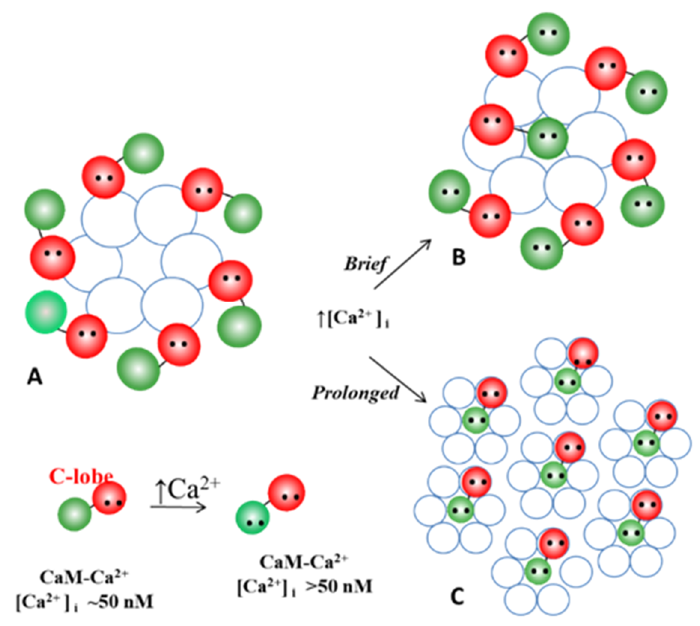
Figure 17. We are proposing that with exposure to high [Ca 2+ ] i , non-gating CaM molecules, bound to connexins by one lobe ( B ), detach from connexins ( C ), enabling the channels to become tightly arranged into crystalline arrays ( C ), interacting mostly hydrophobically with each other. ( A ) Per- meable channel. ( B ) Channel reversibly gated. ( C ) Irreversibly closed channel (“lock-gated”). channel. ( B ) Channel reversibly gated. ( C ) Irreversibly closed channel